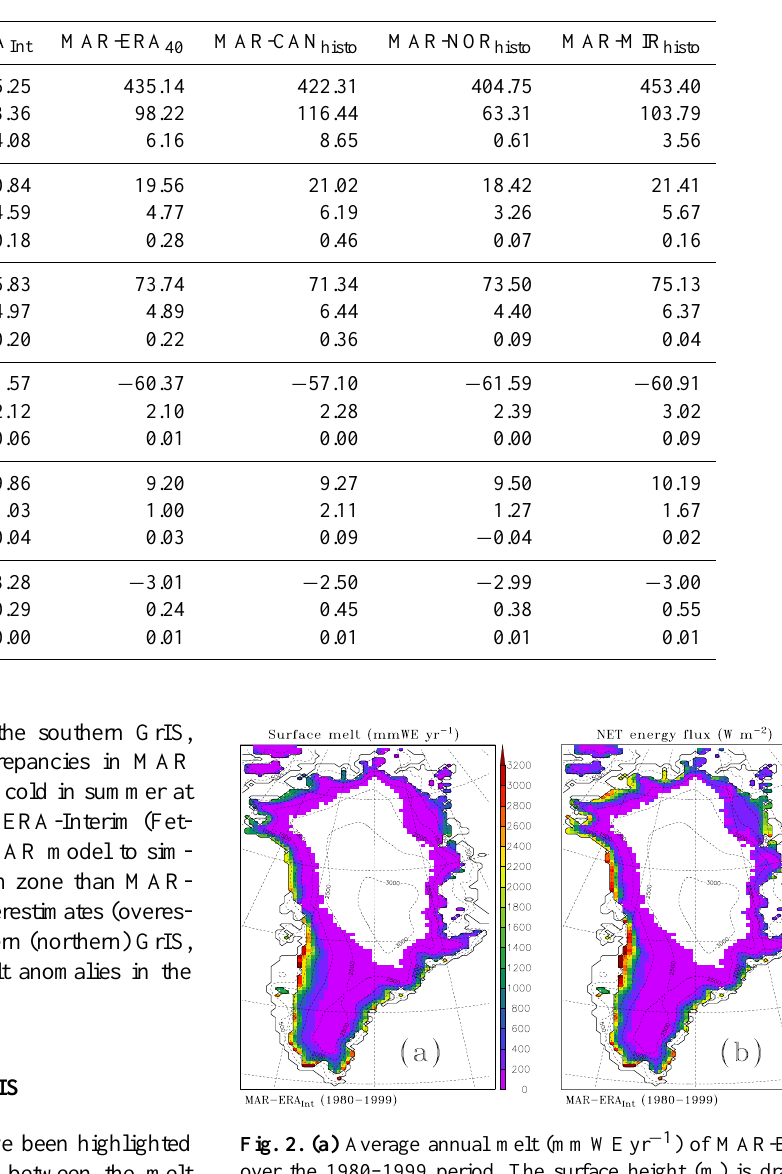
Table 3. Annual melt amount (Gtyr − 1 ) of the GrIS over the 1980–1999 period from different MAR simulations, and the melt energy flux (NET) and SEB components (Wm − 2 ) averaged over the 1980–1999 MSK melt specific to each MAR run.